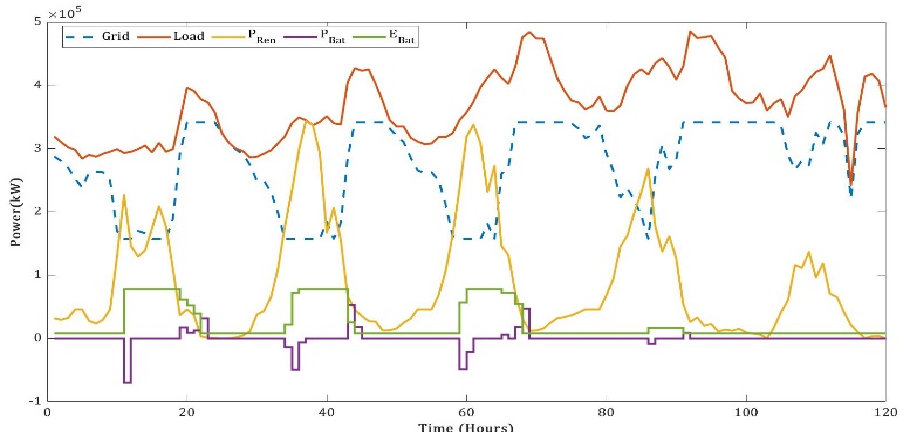
Figure 18. Power distribution with mutation-based ALA-QPSO for the minimum LCoE for 21–26 June.